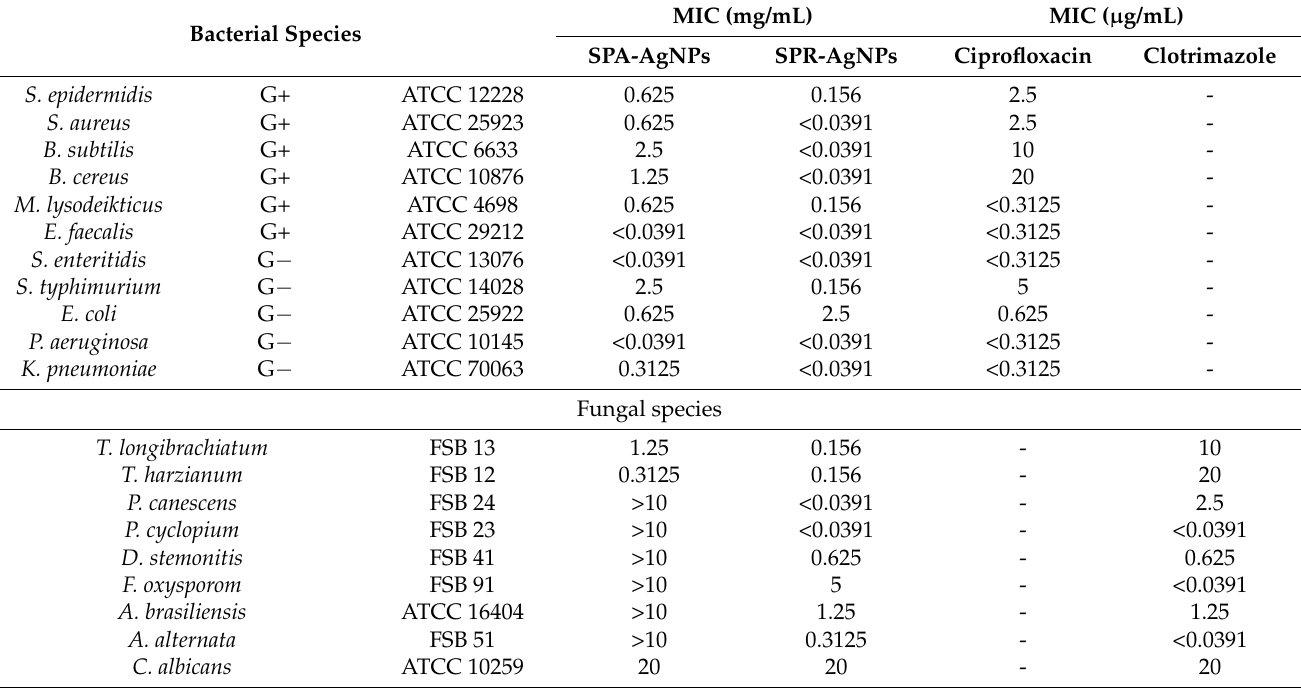
Table 3. Antimicrobial activity of the synthetized